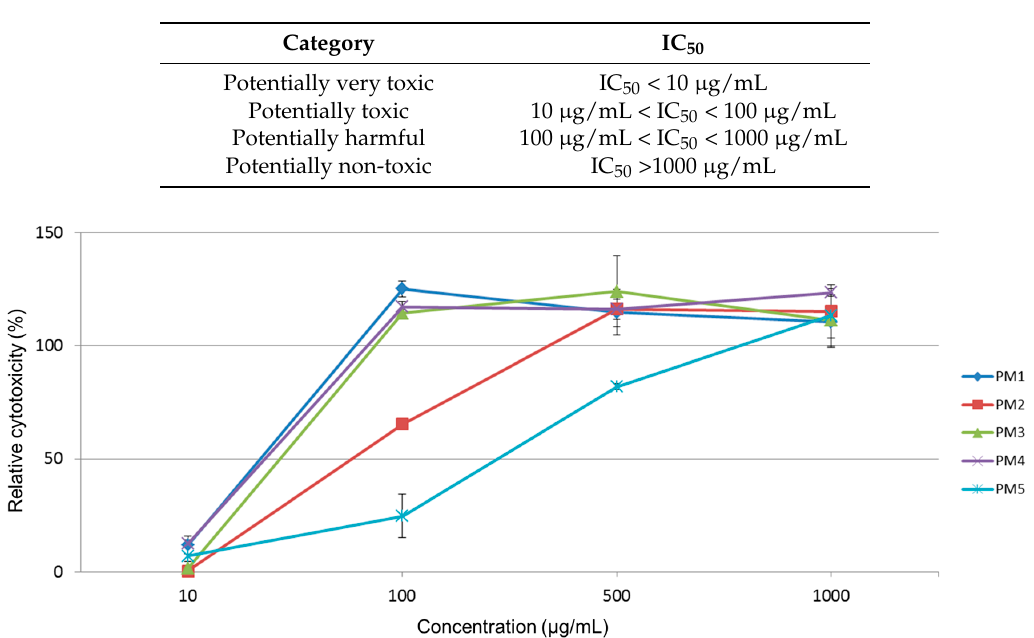
Figure 1. Relative cytotoxicity of Pectinatella magnifica extracts in THP-1 cells after 24 h